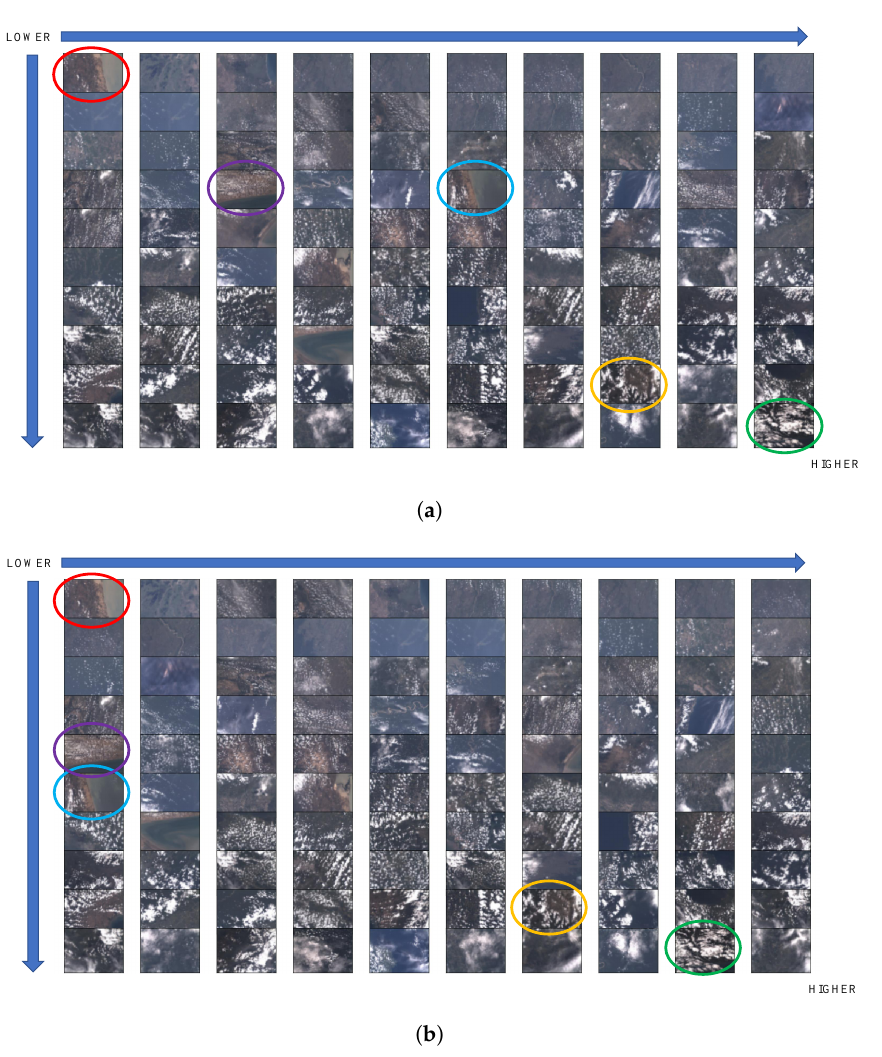
Figure 11. Comparison of PC rank vs. embedded device rank in FACSAT-1 images. Colored circles are used to tag images. ( a ) Rank by PC; ( b ) Rank by embedded device.